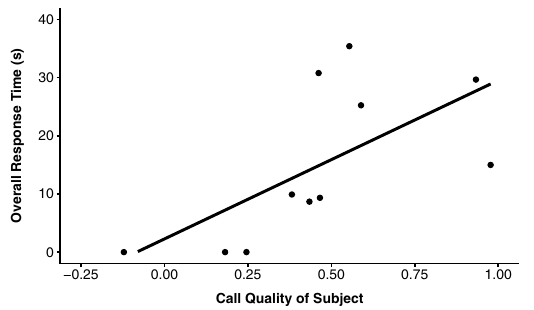
Figure 4. Overall response time (s) to the high-quality playback call in relation to the subjects own call